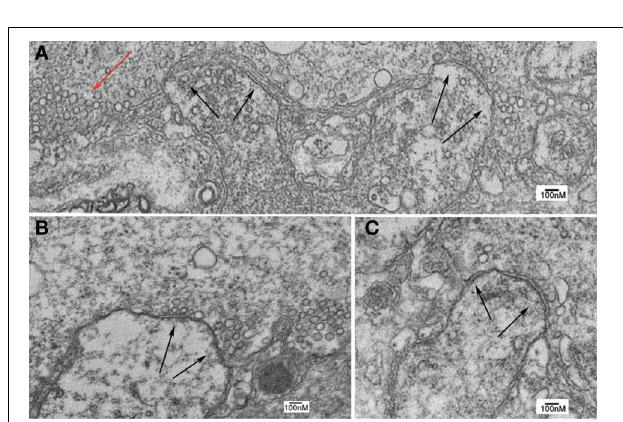
FIGURE 9 | Ultrastructure of squid giant synapse active zones following oligomycin injection. (A–C) Black arrows indicate active zones showing few, if any, synaptic vesicles. Note also the lack of clathrin-coated vesicles and of large vesicular profiles that are generally found in the presence of synapses superfused with RNS60 ASW. Note also the presence of a few vesicles scattered away from the active zone (red arrow).